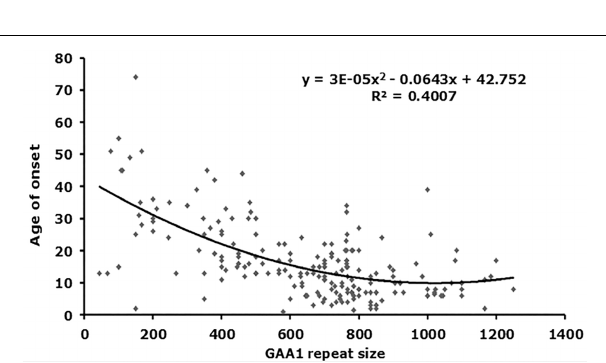
FIGURE 2 | Correlation analysis of GAA repeat size with age of onset. A graph representing GAA1 repeat size v age of onset is shown ( n = 199). The best fit was for a quadratic model, for which the equations and R 2 -values are shown (ANOVA P -values are listed in Table 2 ).